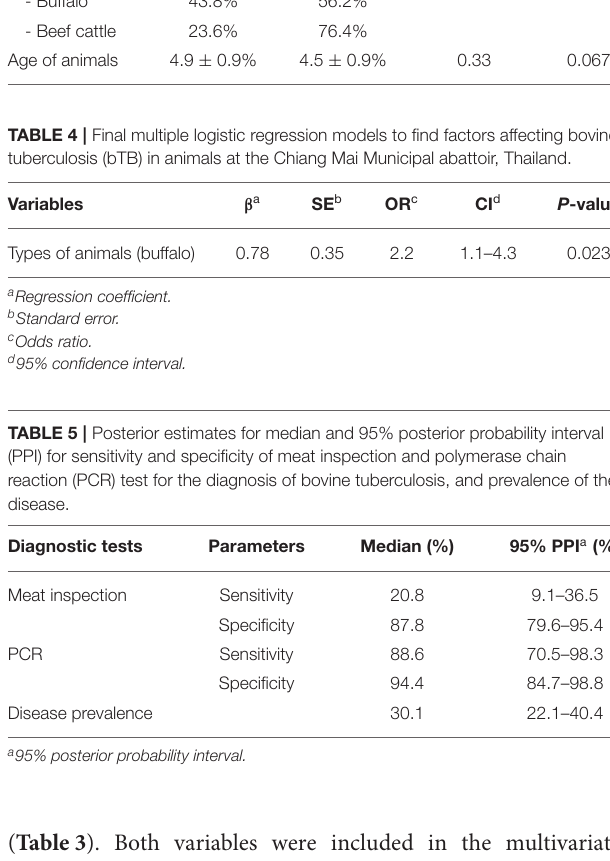
( Table 3 ). Both variables were included in the